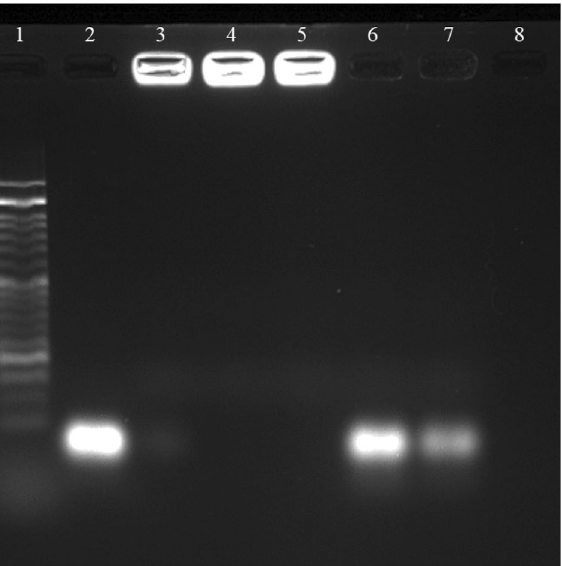
Figure 5. RNase protection assay for the protective effect of [FA-PEGylated/PEI@GuIL@KIT-6] on siRNA. Lane 1 : DNA Ladder (50 bp); Lane 2 : naked siRNA; Lane 3 : siRNA@[FA-PEGylated/PEI@GuIL@KIT-6]